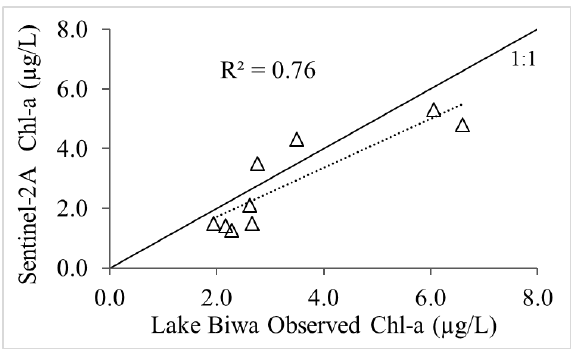
Figure 4. Observed and Sentinel-2A derived chlorophyll-a for Lake Biwa (4 August 2018).